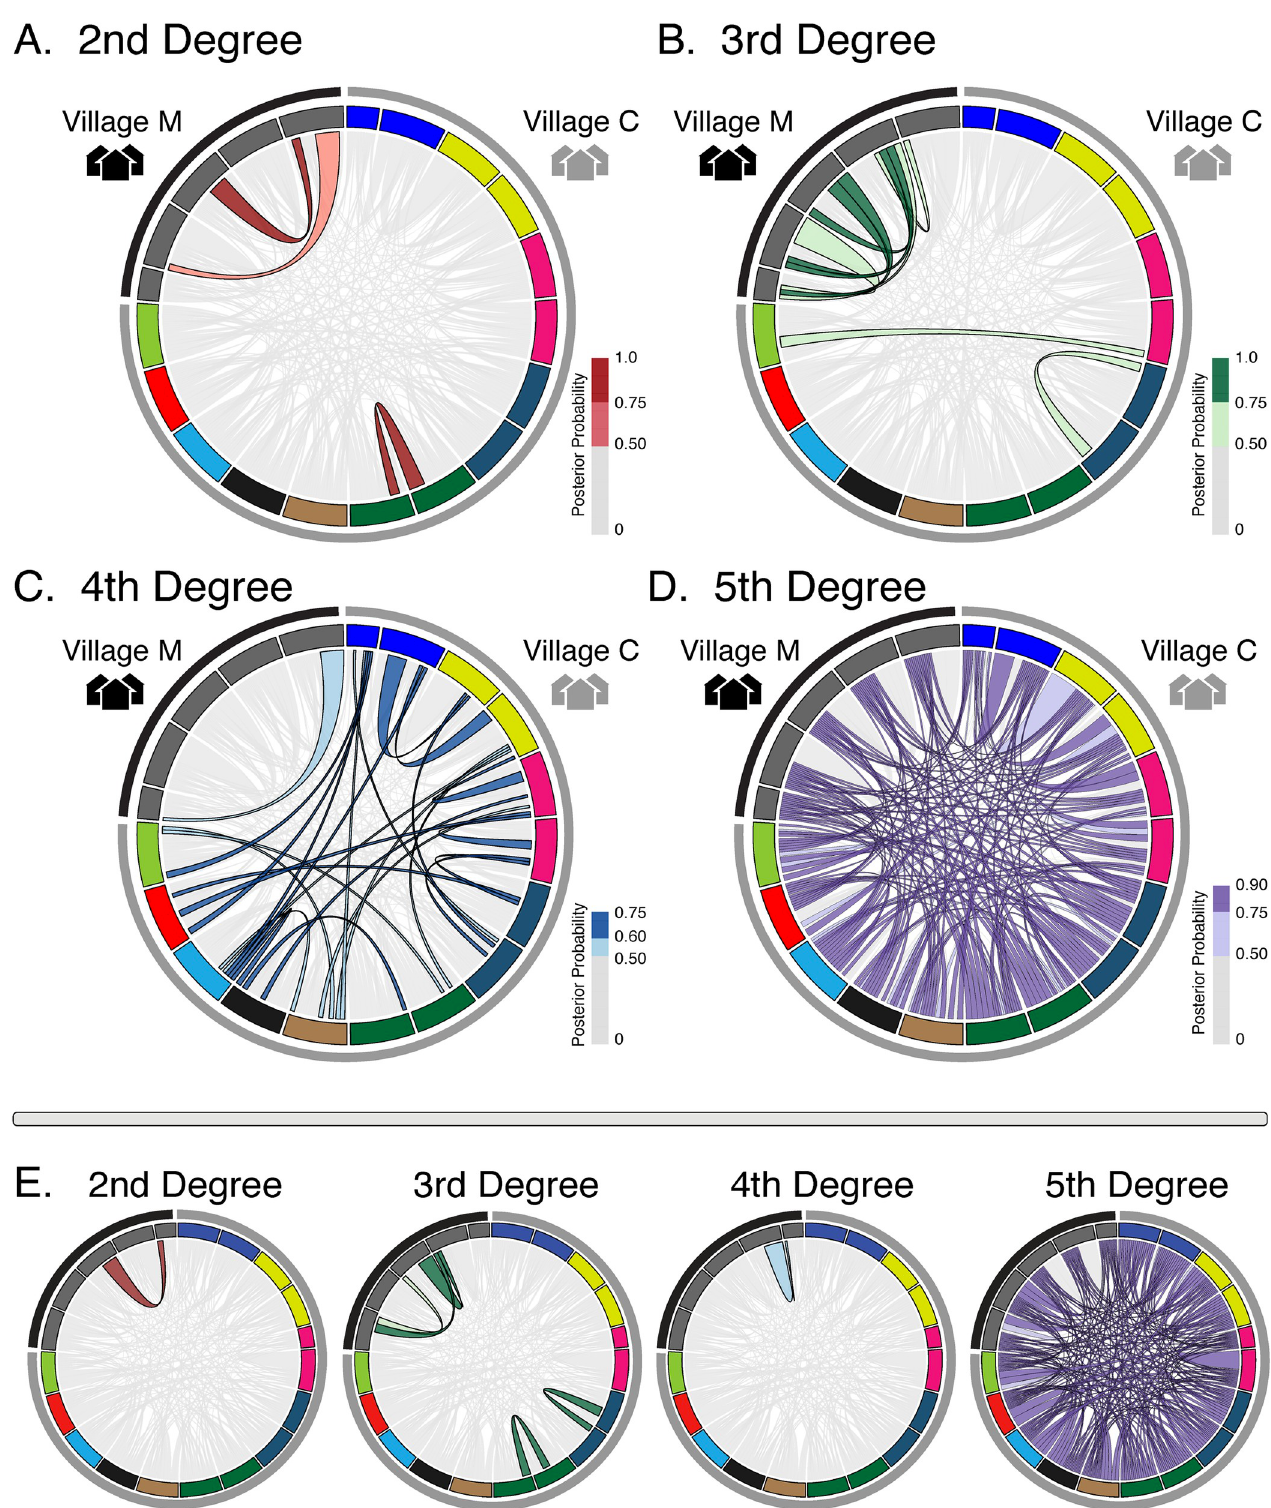
Fig 3. Posterior probability estimates of relatedness among sampled miracidia. Bands represent villages and miracidia are colored by host. All posterior probability estimates are shown in light gray, while colored ribbons represent relationships that have a posterior probability � 0.50. A) Red ribbons representing 2 nd degree (full sibling) relationships among miracidia that have a posterior probability estimate � 0.50 or higher. B) Green ribbons representing 3 rd degree